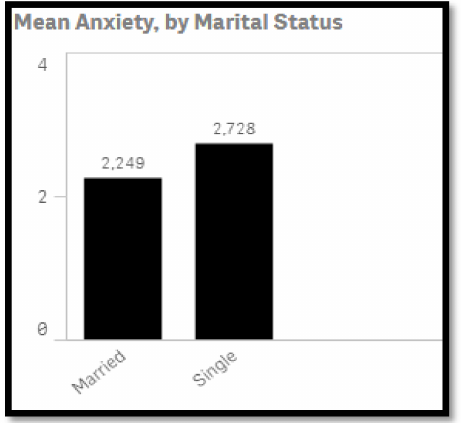
Figure 7. Anxiety, by Marital Status. Source: data study analysis.